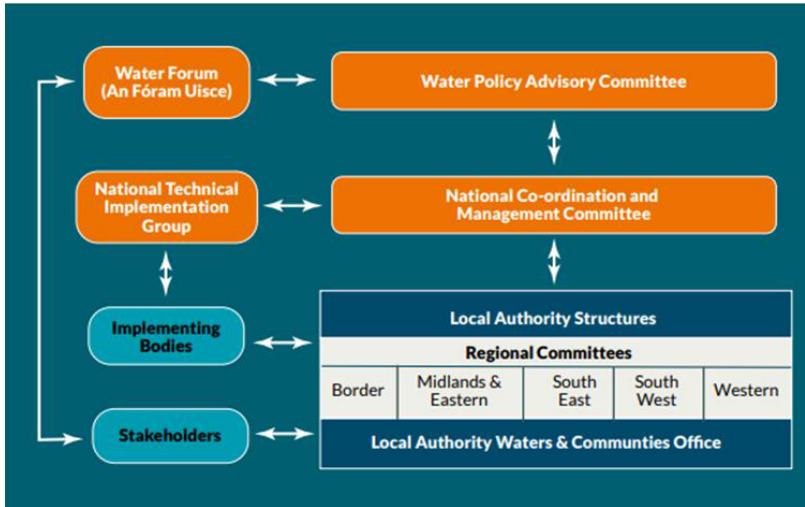
Figure 2. The three-tier governance structure for RBMP implementation [34].